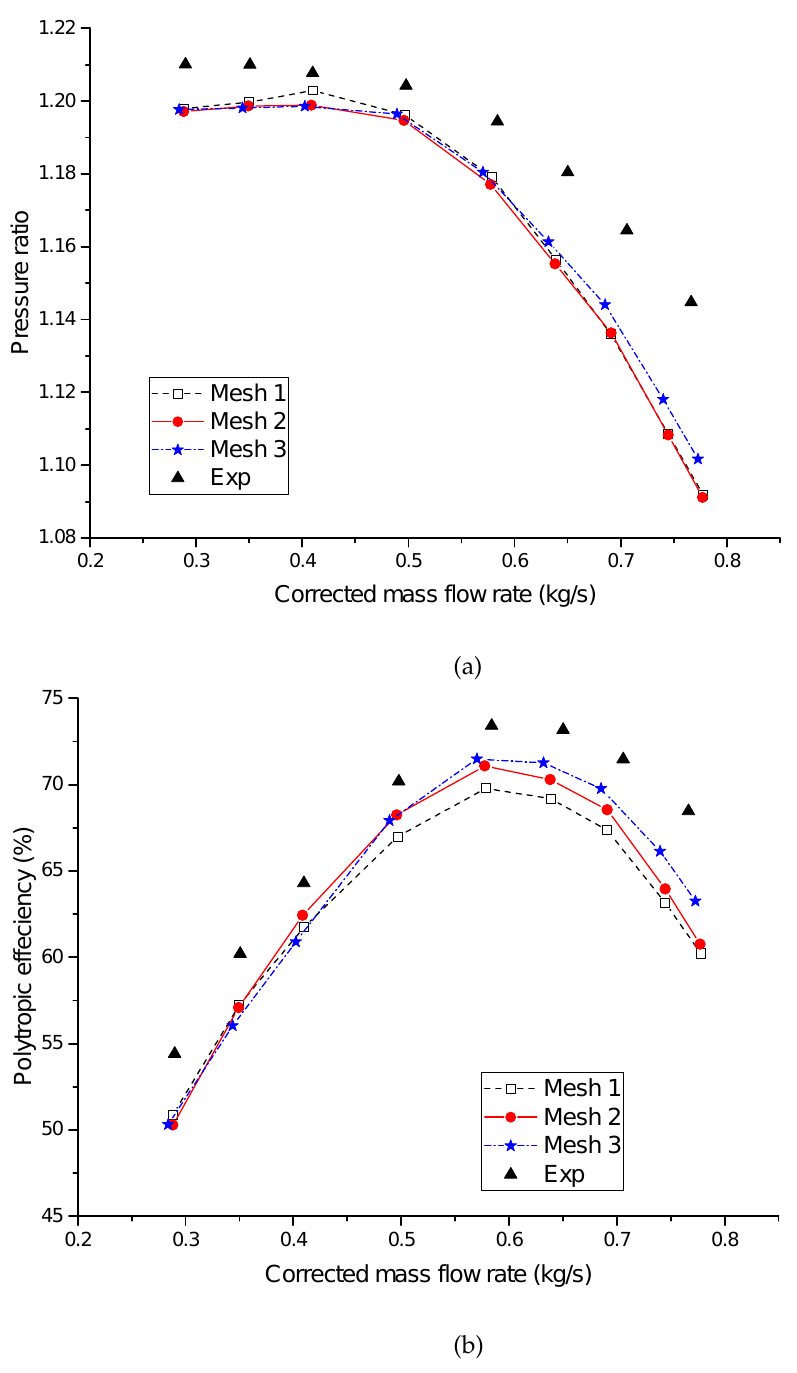
Figure 7. Comparison between the simulation results with different mesh sizes and experimental measurements at the speed of N 1 = − 11k rpm, N 2 = 11k rpm: Pressure ratio ( a ) and polytropic efficiency ( b